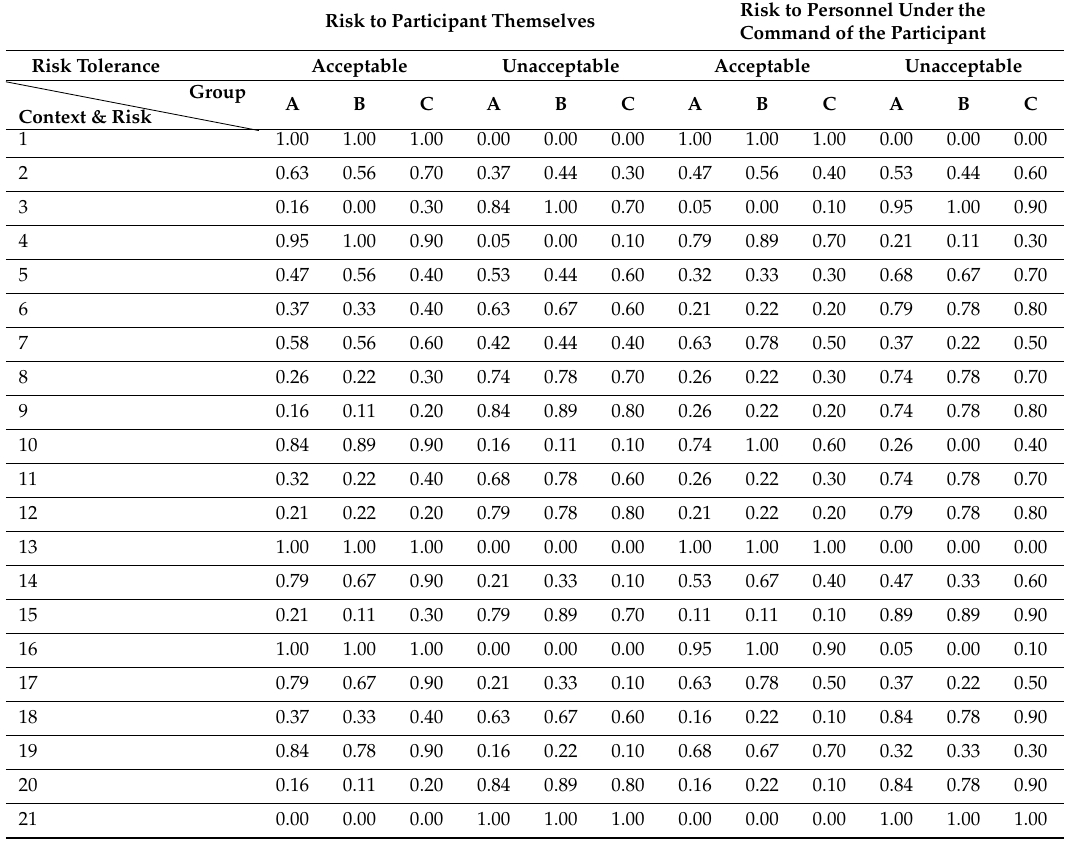
Table A3. Risk tolerance to the participant themselves compared to those under their command. Risk to Personnel Under the Risk to Participant Themselves Command of the